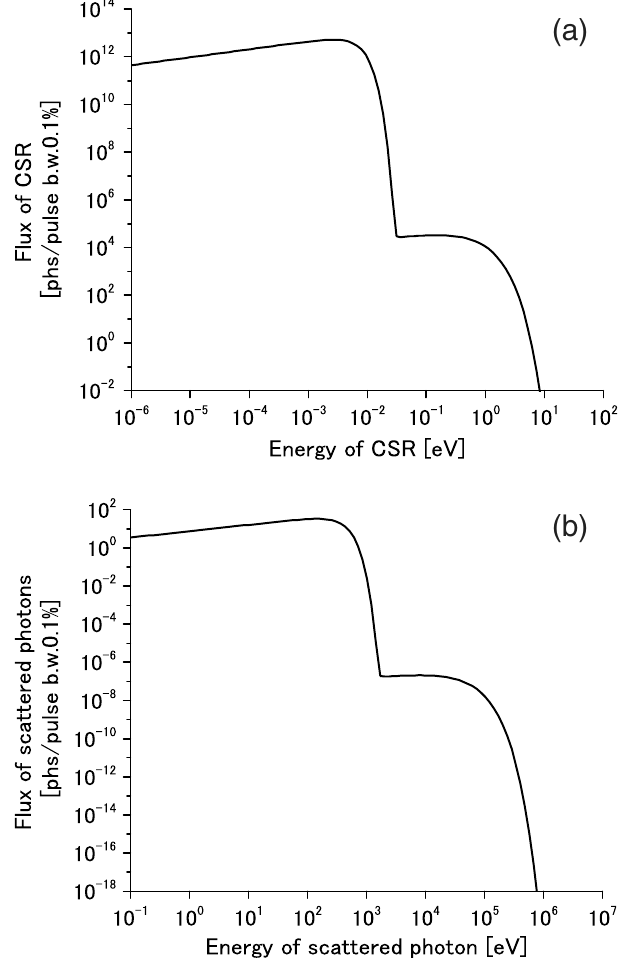
FIG. 4. Spectra of (a) CSR and (b) on-axis x ray in the case of magic mirror. Electron energy, bunch length (cid:3) z , and electron charge is 60 MeV, 0.1 ps, and 77 pC = pulse , respectively. The horizontal acceptance angle is 300 mrad. The average of the transverse beam size over the orbit in the bending magnet is assumed to be 100 (cid:1) 50 (cid:8) m 2